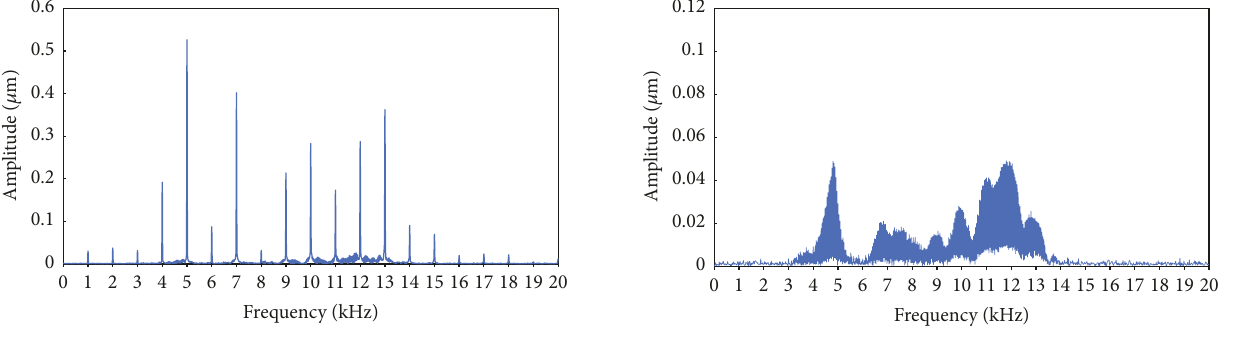
Figure 38: Spectrum of the residual signal of a faulty gear (crack ratio = 45%).